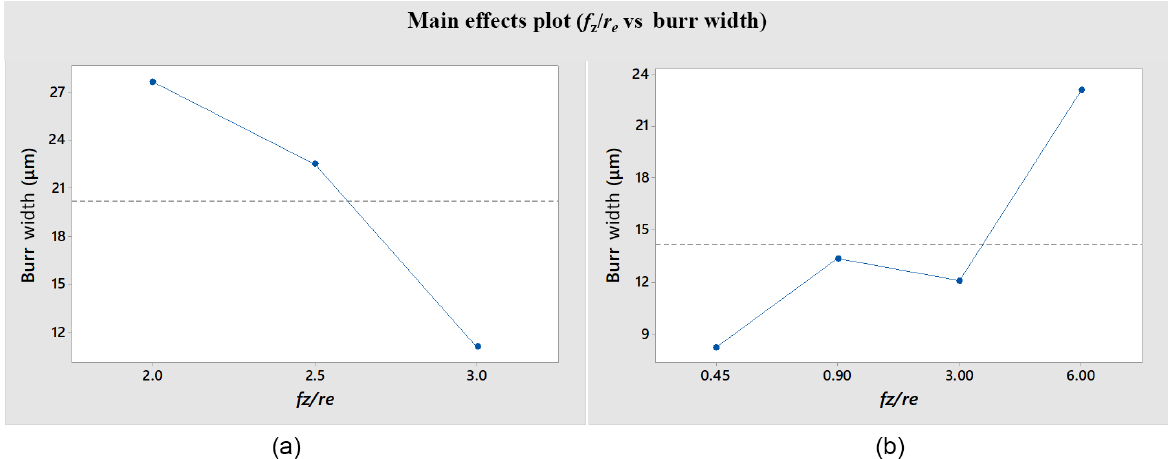
Figure 7. Main effect plot between f z /r e and top burr width (a) data from experiments; (b) data from Syed H. Imran Jaffery (Jaffery et al., 2016)